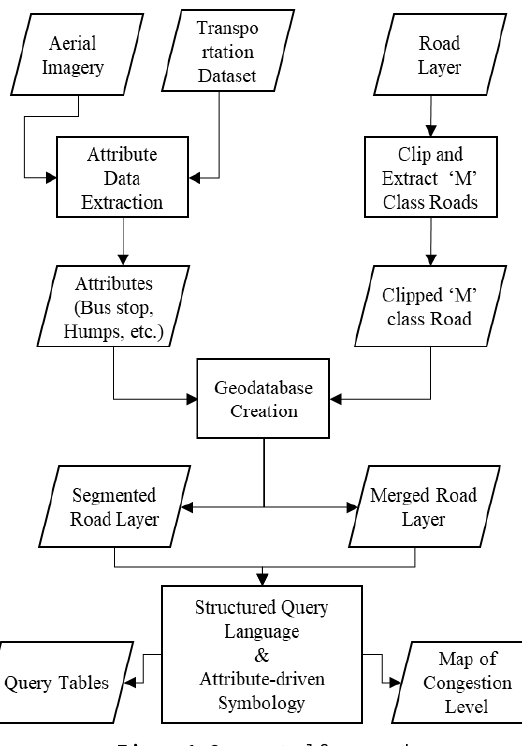
Figure 1 . Conceptual